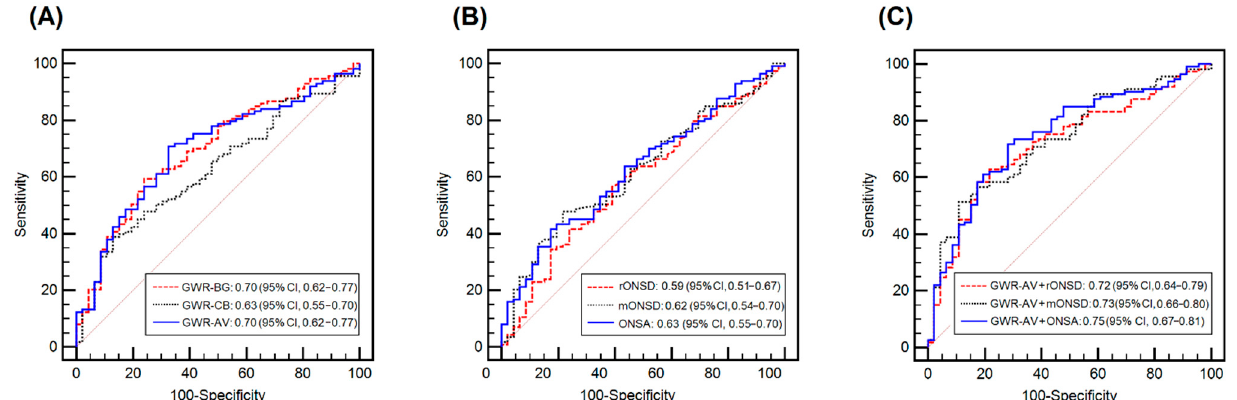
Figure 3. Receiver operating characteristic curve for the prediction of a poor 6-month neurologic outcome. ( A ) The AUCs for GWR-BG, GWR-CB and GWR-AV. ( B ) The AUCs for rONSD, mONSD and the ONSA. ( C ) The AUCs for the combined model with GWR-AV and rONSD, GWR-AV and mONSD, and GWR-AV and the ONSA. AUC: area under the curve, GWR-BG: gray-to-white matter ratio at the basal ganglia level, GWR-CB; gray-to-white matter ratio at the centrum semiovale and high convexity level, GWR-AV: average gray-to-white matter ratio, rONSD, routine optic nerve sheath diameter; mONSD, maximal optic nerve sheath diameter, ONSA, optic nerve sheath area. Table 2. Prognostic accuracies of the predictors from early brain computed tomography for deter- mining a poor 6-month neurological outcome.